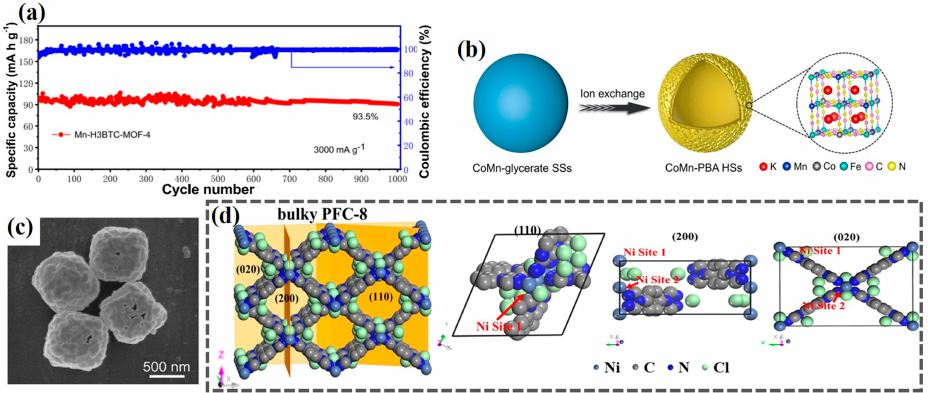
Figure 3. ( a ) Cycling performance of Mn-H3BTC-MOF-4 as the cathode for AZIBs at 3000 mA g − 1 . ( b ) The synthetic process of CoMn-PBA HSs. ( c ) SEM image of CuMn-PBA DSNBs. ( d ) Atomic struc- ture of the PFC-8 framework with an illustration of (110)-, (200)-, and (020)-exposed crystal